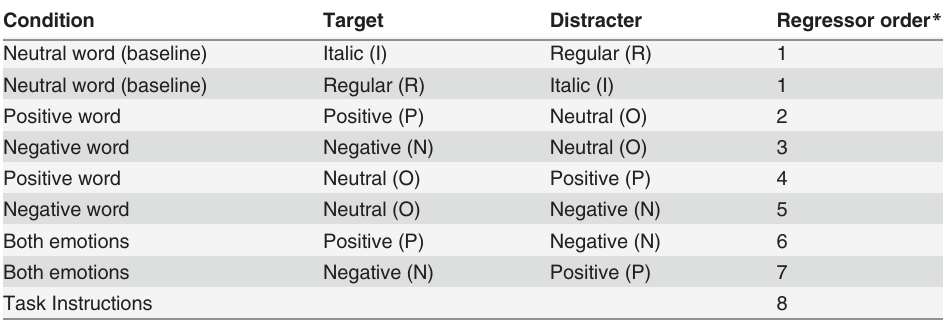
Table 1. fMRI task